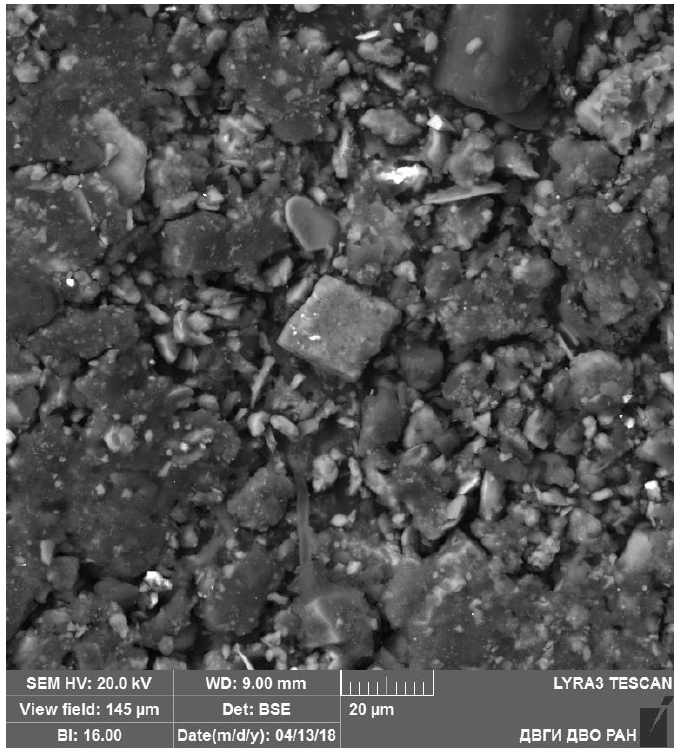
Figure 3. General view of a dust washout sample. According to the data of scanning electron microscopy, the main components in the samples were Fe, As, and S concentrated in finely dispersed phases of ore minerals, pyrite (FeS 2 ) and arsenopyrite (FeAsS) (Figure 4A), and also microcrystals shaped as tetragonal dipyramid, which are, presumably, marcasite (FeS 2 ) (Figure 4B). The dust washout also included particles containing Zn and Pb represented by morphotypes of such ore minerals as sphalerite (Figure 4C) and galena (Figure 4D).